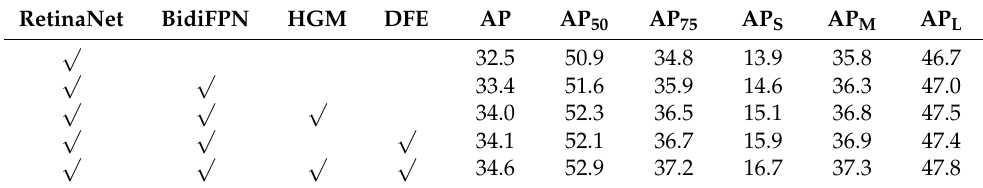
Table 3. Effect of each component on COCO val-2017. BidiFPN: bidirectional feature pyramid network; HGM: High-level Guided Model; DFE: Dilated Feature Enhancement.